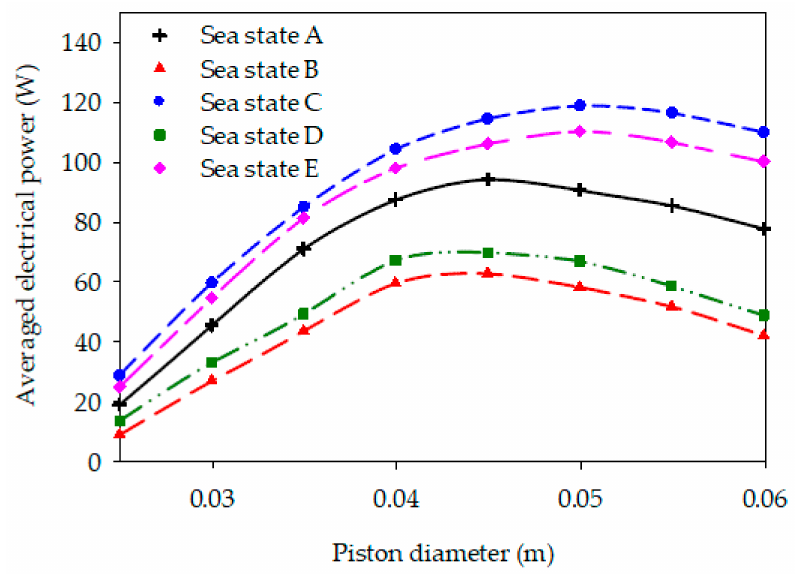
Figure 9. Averaged power of generator versus piston diameter corresponding to different sea